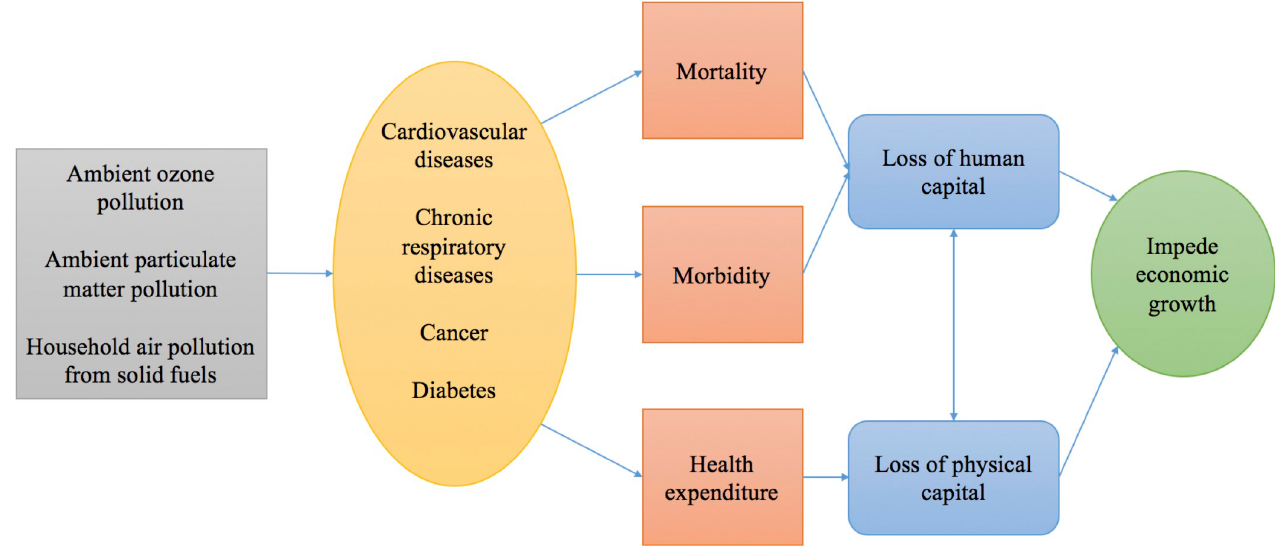
Fig 1. Underlying mechanisms linking NCDs associated with air pollution to economic growth.